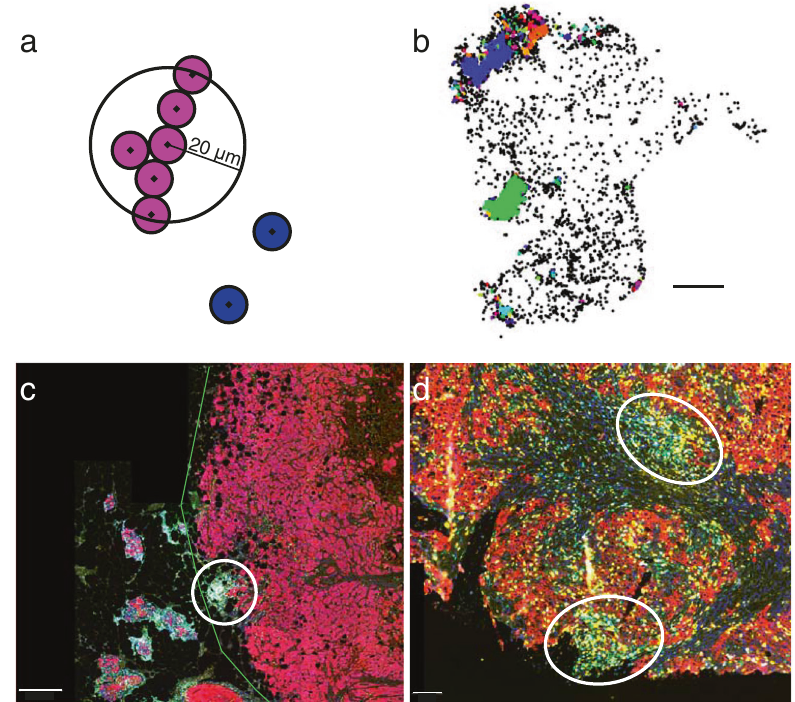
Fig. 3 Lymphocyte clusters (LCs) within tumors. a Cartoon illustrating density-based clustering algorithm (DBSCAN). LCs contain at least fi ve lymphocytes within a circle with a diameter of 40 μ m. b Figure illustrating LCs identi fi ed in a tumor sample from a poor outcome patient. Each color corresponds to a unique LC. Black points are isolated lymphocytes. c , d Tumor samples with heterotypic LCs (circled) and isolated lymphocytes from ( c ) poor outcome and ( d ) good outcome. Scale bar = 500 μ m in ( c ) and 100 μ m in ( d ). Green line is the pathologist ’ s outline of the tumor region. Color code: Nuclei (DAPI, dark blue), T cells (CD3 + ; green), B cells (CD20 + ; cyan), cytotoxic T cells (CD8 + ; yellow), regulatory T cells (FoxP3 + , yellow), and cancer cells (Pan-cytokeratin cells; magenta in ( c ) and dark brownish red in ( d